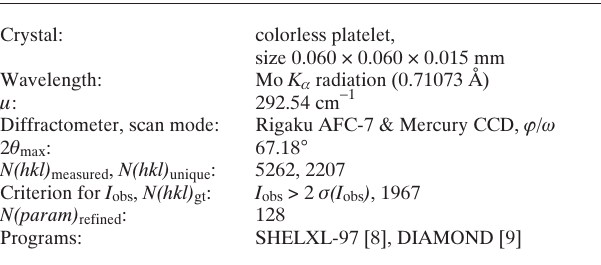
Table 4. Data collection and handling.